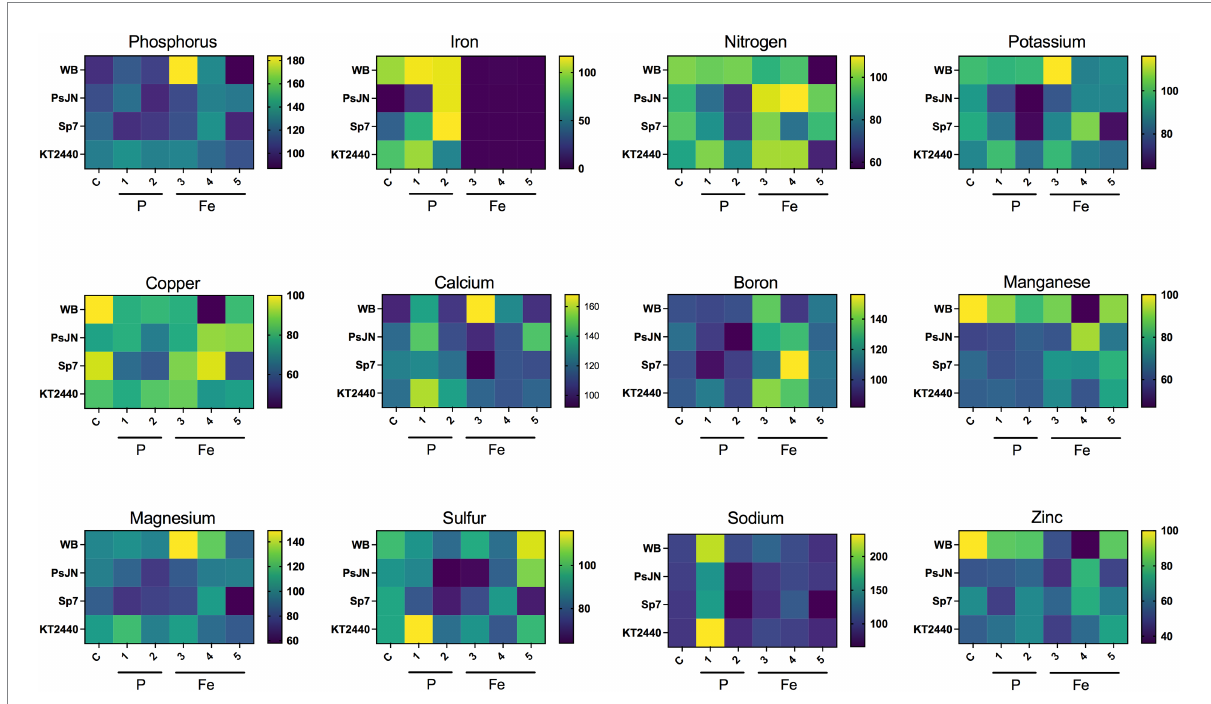
FIGURE 5 Effects on the nutrient content of Arabidopsis thaliana plants of different sources of phosphorus and iron and the inoculation with beneficial rhizobacteria. The nutritional treatments are indicated in the X-axis of the figures, being (C) the full culture media, 1 mM KH 2 PO 4 and 100 μ M FeSO 4 ; (1) 0.05 mM KH 2 PO 4 /0.95 mM Ca 3 PO 4 ; (2) 0.05 mM KH 2 PO 4 ; (3) 25 μ M FeSO 4 ; (4) 0.25 μ M FeSO 4 /24.75 μ M, and (5) 0.25 μ M FeSO 4 . The Y-axis represents the inoculation treatments, with (WB) without bacteria; (PsJN) Paraburkholderia phytofirmans PsJN; (Sp7) Azospirillum brasilense Sp7 (Sp7), and (KT2440) Pseudomonas putida KT2440. Each square represents data relative to the C/WB treatment (100%). The color from yellow to blue indicates high to low nutrient